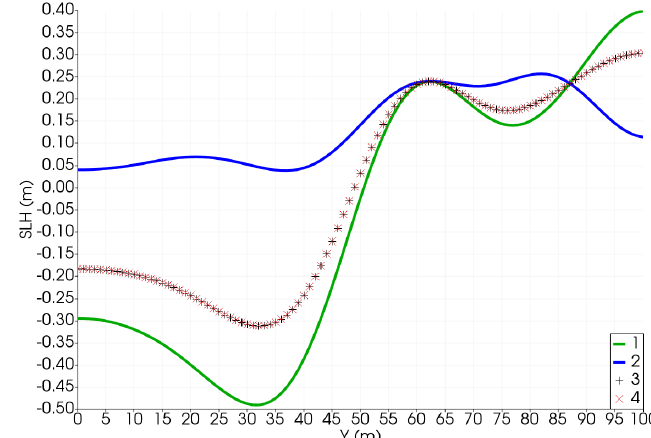
Figure 5. Sea level function on Γ in at different iterations (1— ξ ( 1 ) at the first iteration; 2— ξ ( 2 ) at the first iteration; 3— ξ ( 1 ) at the last iteration; 4— ξ ( 2 ) at the last